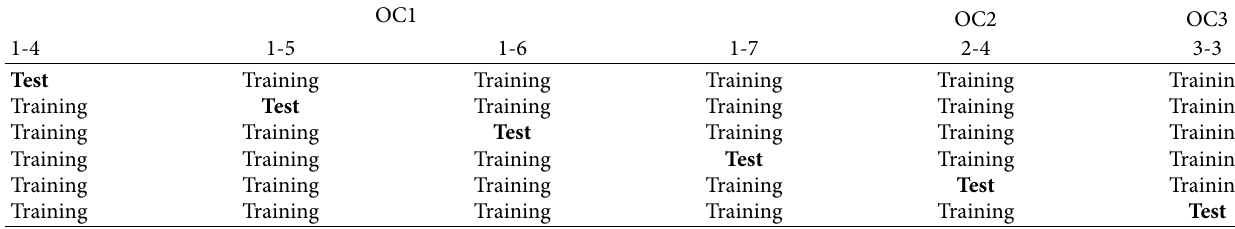
Table 2: Training and testing GLL-Weibull model development.